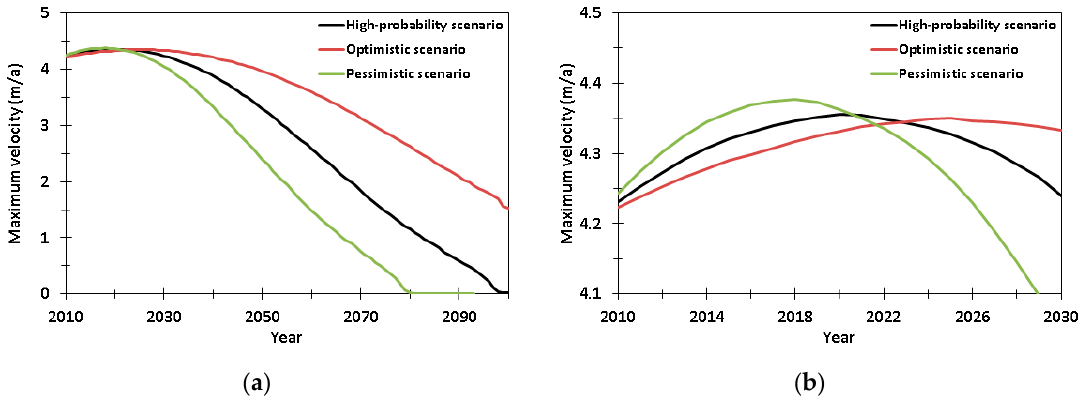
Figure 12. The simulated maximum ice flow velocity as a function of time under three hypothetical climate scenarios during 2010~2100 ( a ) and during 2010~2030 ( b ).